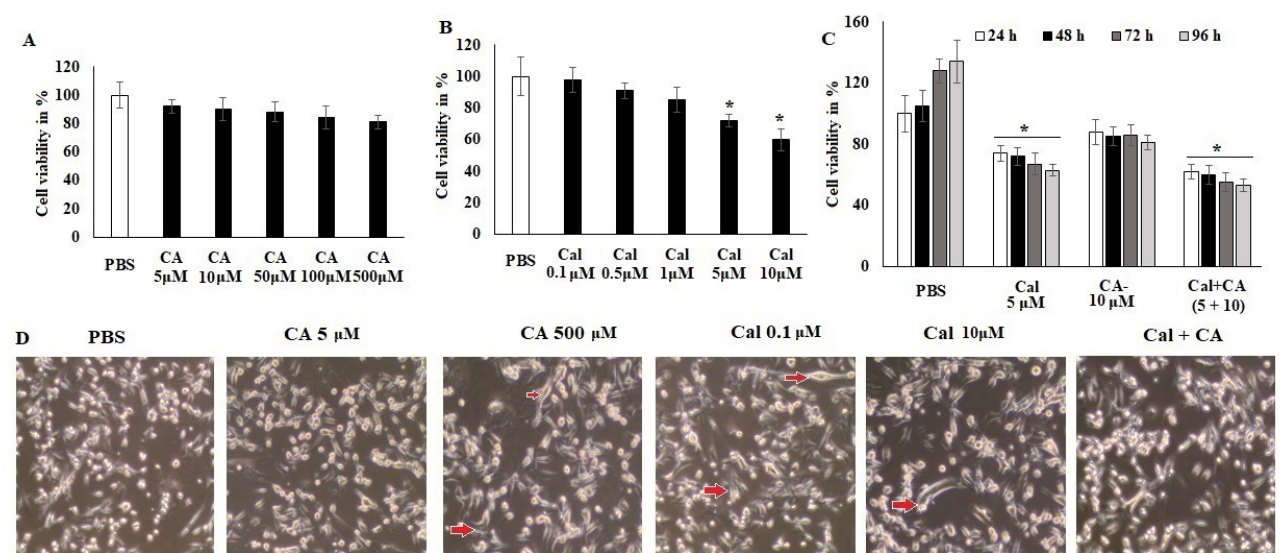
Figure 2. CA and Cal effect on cell growth inhibition and induced inflammation in colon HCT116 cells. Colon cell lines were supplemented with CA (5–500 µ M) and Cal (0–10 µ mol), vehicle control (PBS) and cell viability was quantified using MTT tetrazolium salt method. ( A ) HCT116 cells were supplemented with CA for 24 h, cell viability and cell morphology were assessed using MTT assay and inverted phase-contrast microscope, respectively. ( B ) HCT116 cells were exposed to calcitriol (0.1–10 µ M), and cell viability cell morphology was observed using MTT assay and inverted phase-contrast microscope respectively. ( C ) IC 20 dose of both synergistic effects on HCT116 were analyzed. ( D ) HCT116 Cells were supplemented with CA and Cal reduce inflamed cellular morphology and were observed under inverted phase-contrast microscope (200X magnification power). Data were obtained from three separate experiments and expressed as mean ± SEM. *p < 0.05 represents significance compared to treated group (CA and CAL) against PBS (untreated group.